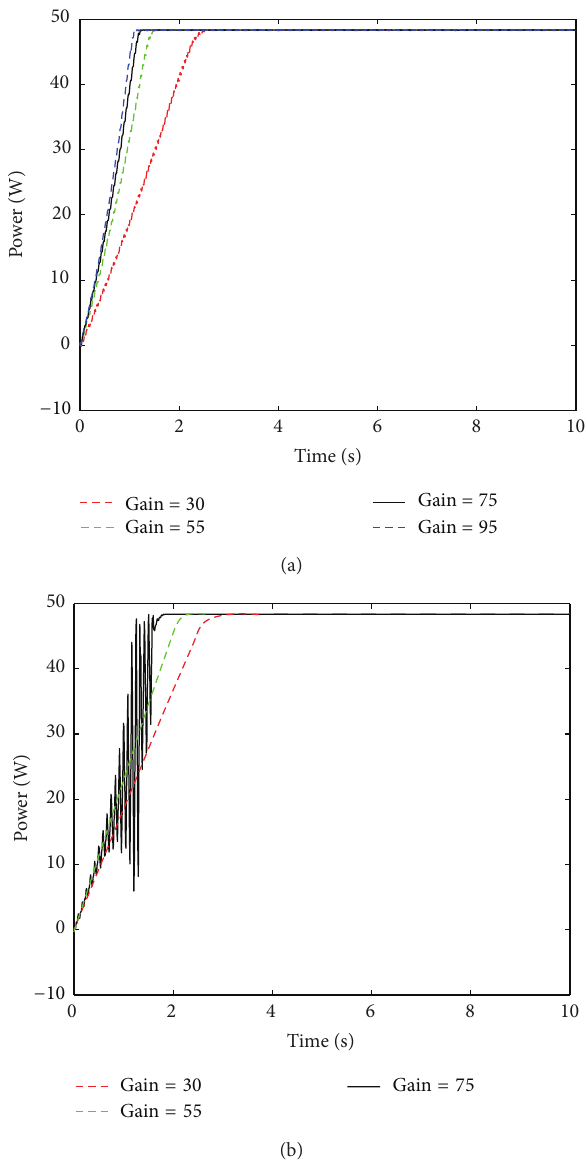
Figure 15: Sensitivity of BICO MPPT and ESC MPPT to the gain variation of